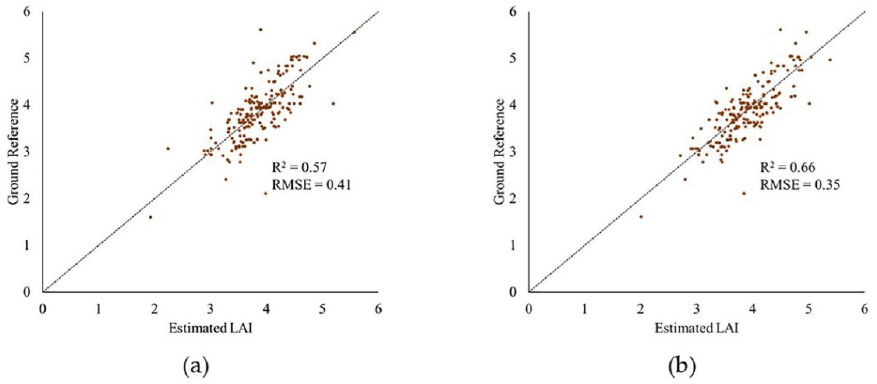
Figure 23. Plot of estimated LAI vs. ground reference: ( a ) original and ( b ) with outliers removed from PhenoRover data (7/24/2020) using PointCleanNet method. from PhenoRover data (24 July 2020) using PointCleanNet method.